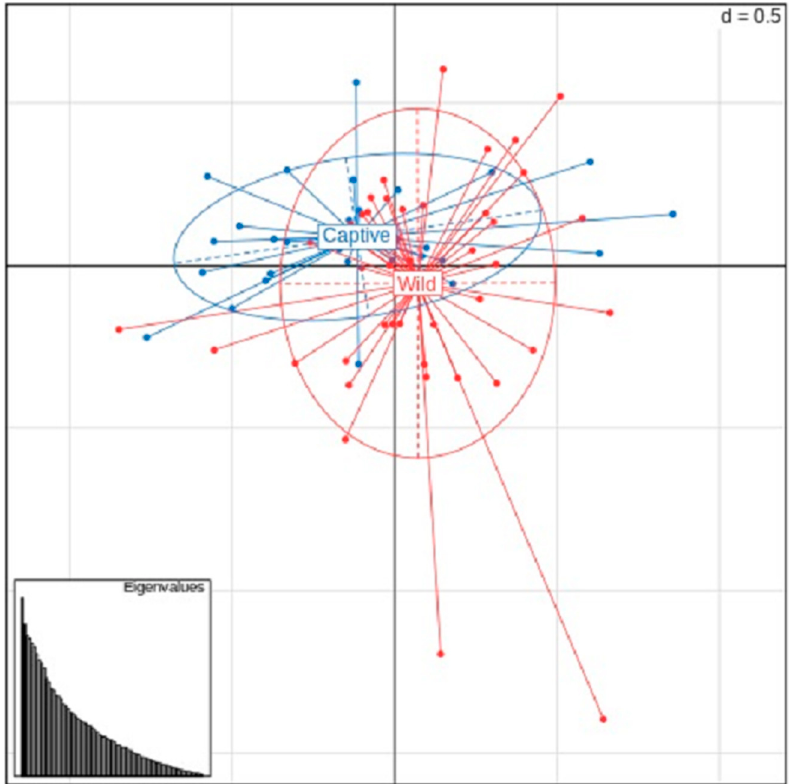
Figure 3. First and second components of the principal component analysis of 139 SNPs in the captive and wild populations of the Tsushima leopard cat. The percentages of variation explained by the first two axes were 4.97% and 4.24%, respectively. Each ellipse included 67% individuals from each